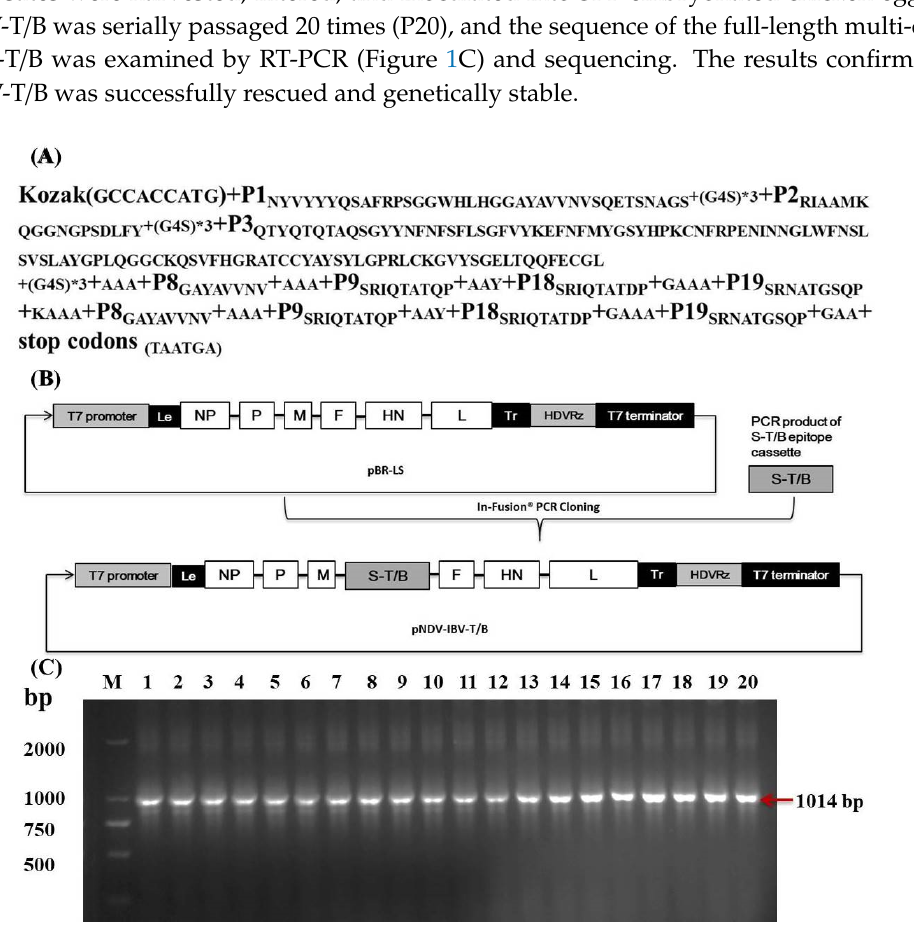
electrophoresis after 20 passages of rNDV-IBV-T/B via RT-PCR; the amplified bands were all